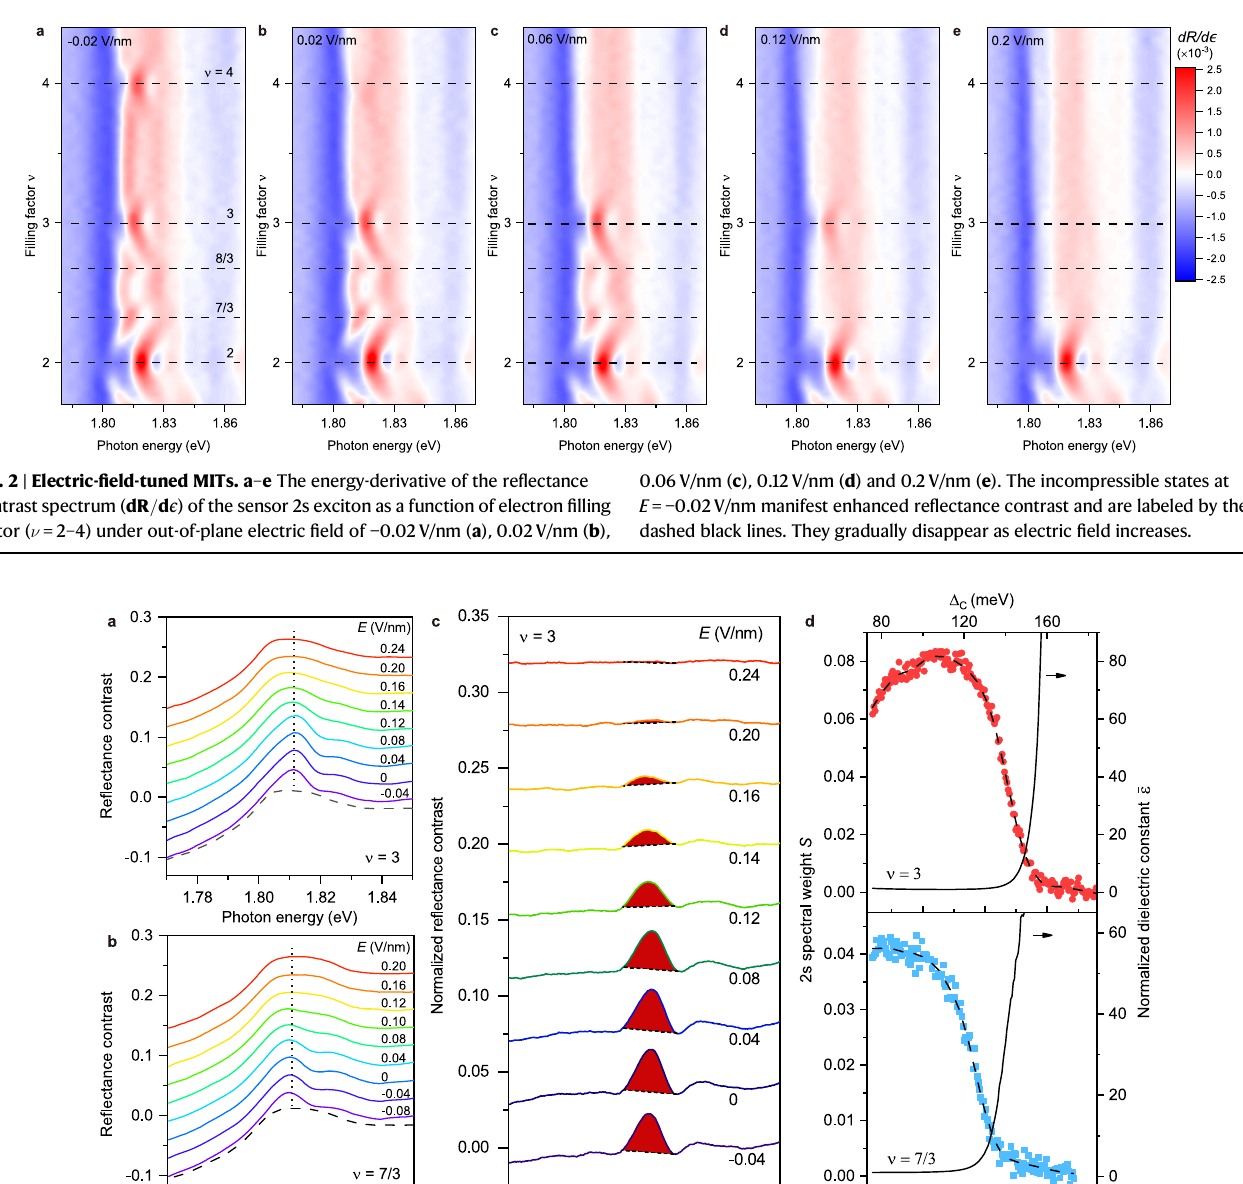
Fig. 3 | Dielectric catastrophe near the Mott and Wigner – Mott transitions. a , b Re fl ectance contrast spectrum of the sensor 2s exciton under varying electric fi eldsat fi xedelectron fi llingfactorof ν =3( a )and7/3( b ).Thespectraarevertically displaced by a constant 0.03. The dashed lines represent the re fl ectance contrast spectra at high electric fi elds (0.28V/nm and 0.24V/nm for ν =3 and 7/3, respec- tively), in whichthe broadhumpscorrespond to the band-to-band transitions.The verticaldottedlinesdenotethe2sexcitonpeak. c ,Re fl ectancecontrastspectrumat ν =3, normalized by that at 0.28V/nm (in the metallic phase), at representative electric fi elds. The spectral weight S is extracted by integrating the shaded area .